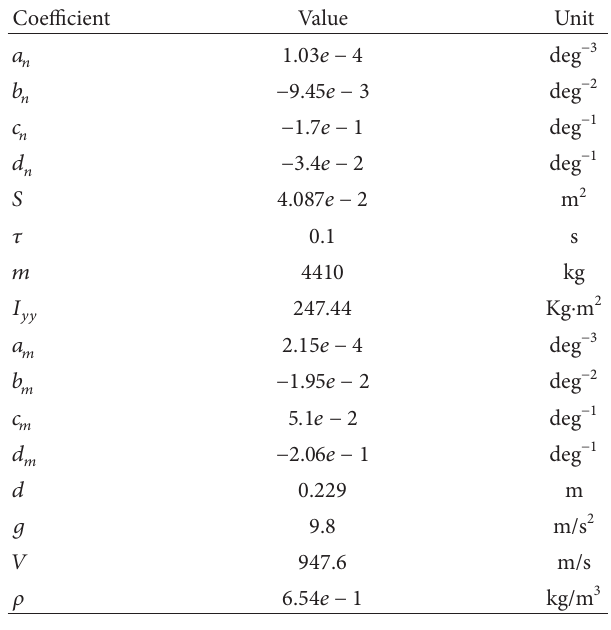
Table 1: Coefficients of the flight vehicle